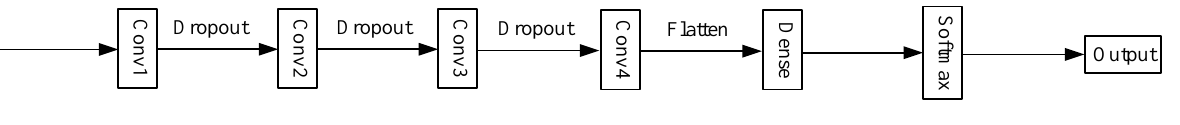
Figure 7. Implementation of our